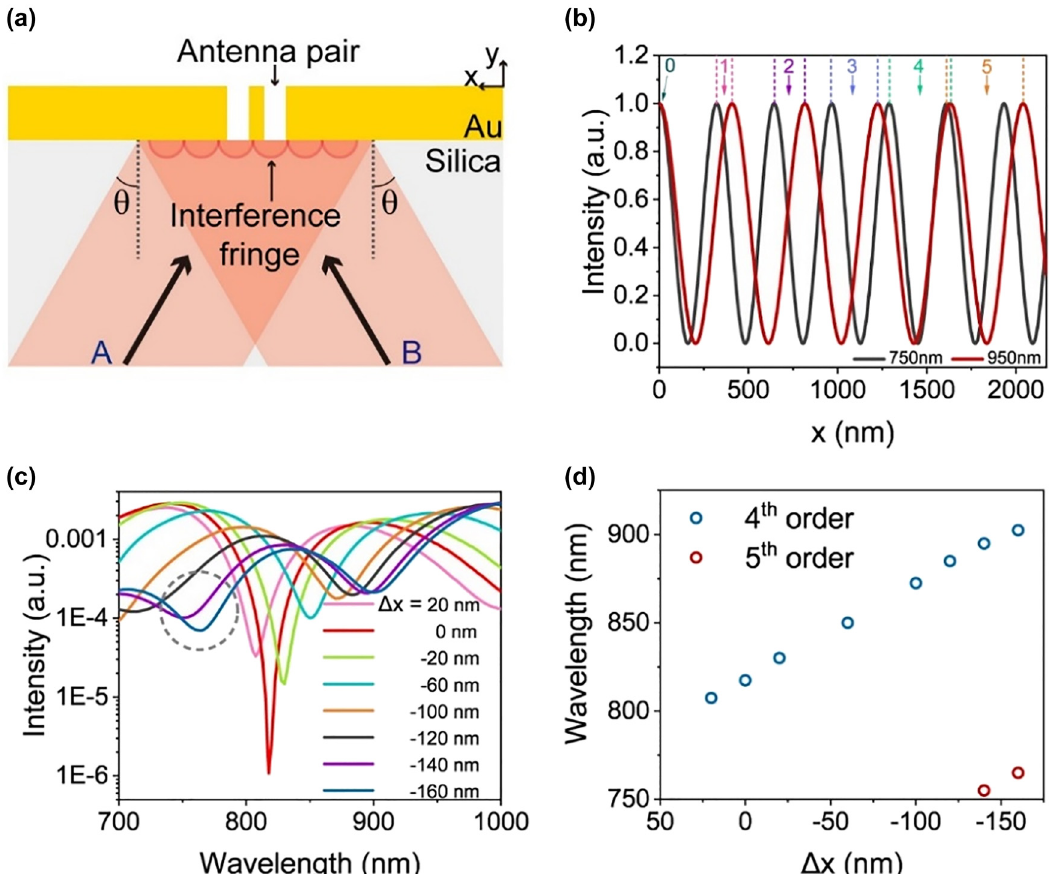
Figure 4: Calculation results of the sensor using the dispersive interference fringe light source. (a)Schematicofthedispersiveinterferencefringelightsourcewithaninclinationangleof θ .(b)Calculatedelectric fi eldintensityversus x for λ of 750 and 950 nm. The number refers to the interference order. (c) Calculated output spectra for various displacements. (d) Calculated extinction wavelength versus the